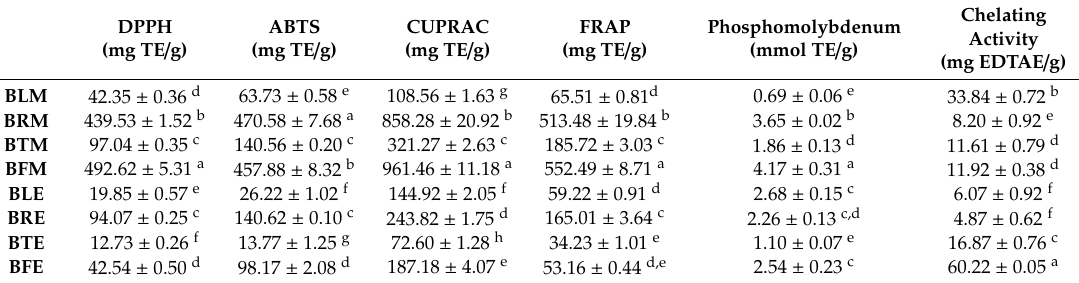
Table 6. Antioxidant properties of B. gymnorhiza